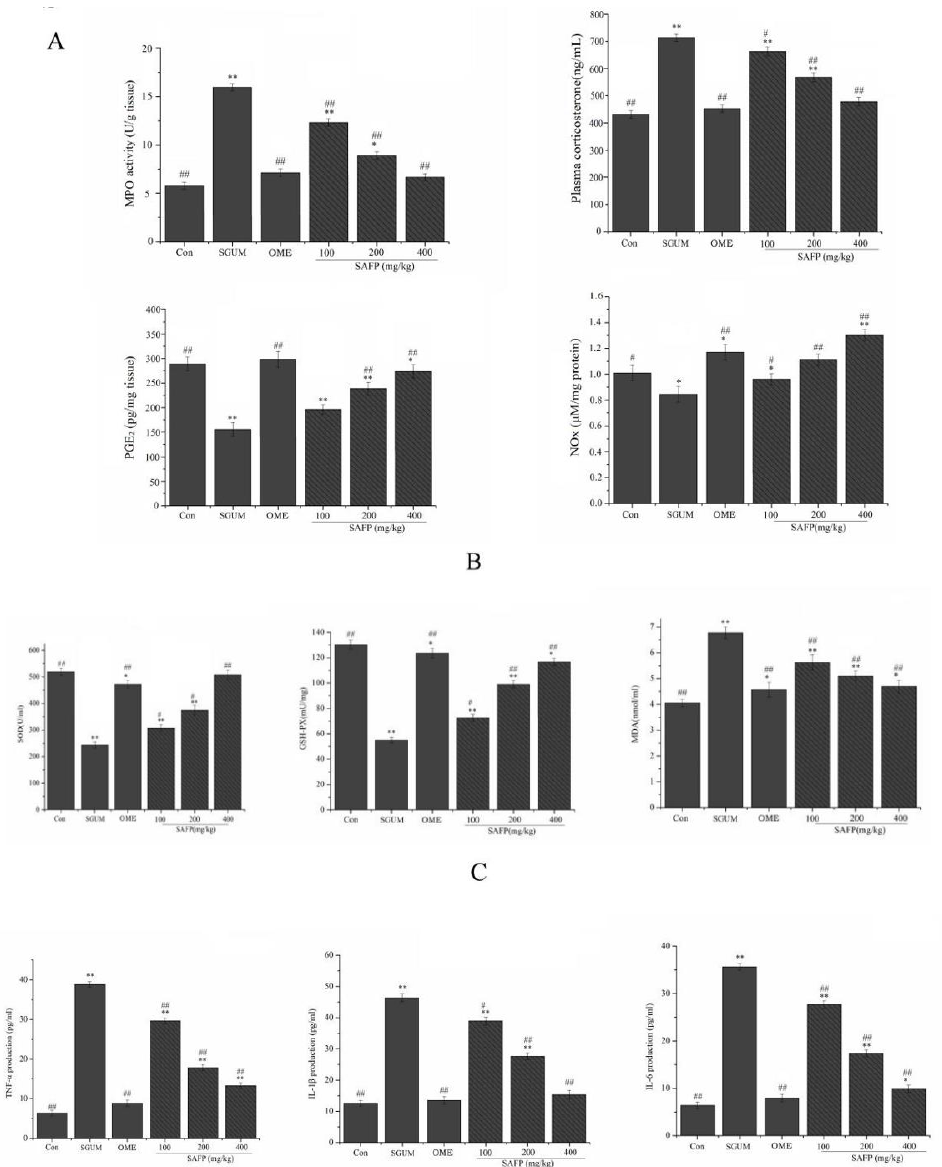
Figure 3. SAFP alleviates the inflammation and oxidative stress damage in SGUM rats. ( A ) Myeloperoxidase (MPO) activity; plasma corticosterone levels; the mean content of gastric Prostaglandin E2 (PGE2) and Nitrate/nitrite (NOx). ( B ) Effect of superoxide dismutase (SOD) activity; glutathione peroxidase (GSH-Px) activity; malondialdehyde (MDA) level. ( C ) The concentration of tumour necrosis factor-α (TNF-α), interleukin-1β (IL-1β) and interleukin-6 (IL-6) were determined by ELISA. Data are represented by mean ± SD ( n = 10). * p < 0.05, ** p < 0.01, vs. control group. # p < 0.05, ## p < 0.01, vs. SGUM group.